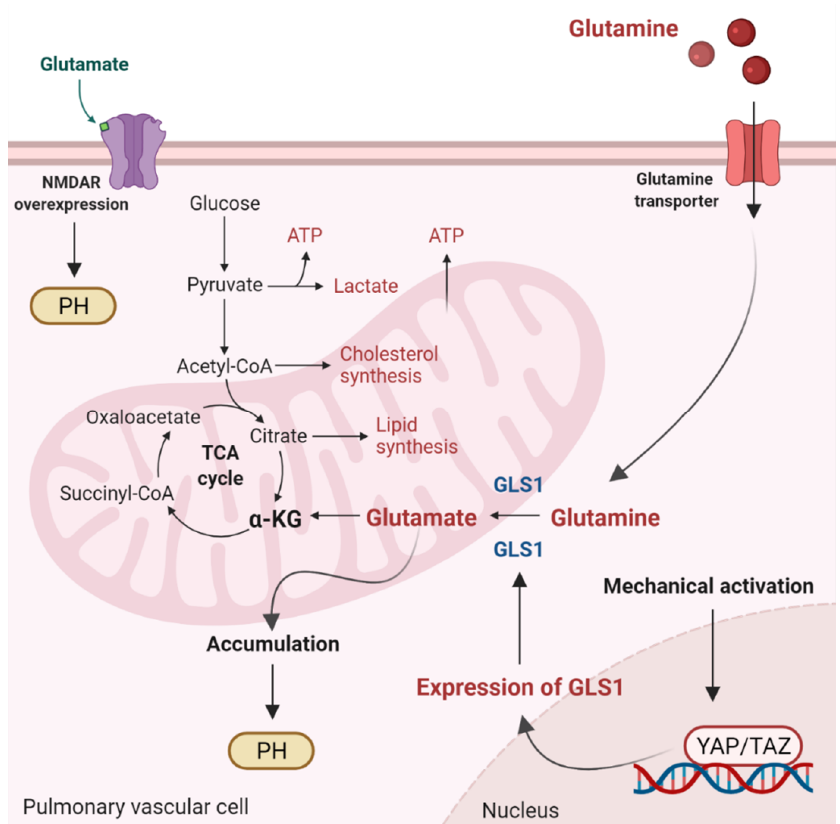
Figure 2. Glutaminolysis and glutamate accumulation contribute to pulmonary hypertension (PH). Glutaminolysis is a mitochondrial process responsible for obtaining cellular energy from the break- down of glutamine. In this cellular pathway, glutamine is converted into glutamate, aspartate, CO 2 , pyruvate, lactate, alanine, and citrate. Initially, glutamine enters the pulmonary vascular cells via a glutamine transporter and is deaminated to glutamate by glutaminase (GLS1). Subsequently, glu- tamate is converted to α-ketoglutarate (α-KG) by glutamate dehydrogenase. α kg enters the tricar- boxylic acid (TCA) cycle, where it is decarboxylated by α kg dehydrogenase to succinyl-CoA and CO 2 , providing energy for proliferating cells. Accumulation of glutamate in pulmonary vascular cells promotes PH. In addition, stiffening of the extracellular matrix in remodeled pulmonary cells activates the transcriptional coactivators Yes-associated protein 1 (YAP) and TAZ, leading to upreg- ulation of GLS1 and enhanced glutaminolysis. Furthermore, in remodeled pulmonary arteries, the N-methyl-d-aspartate receptor (NMDAR) is overexpressed and overactivated.